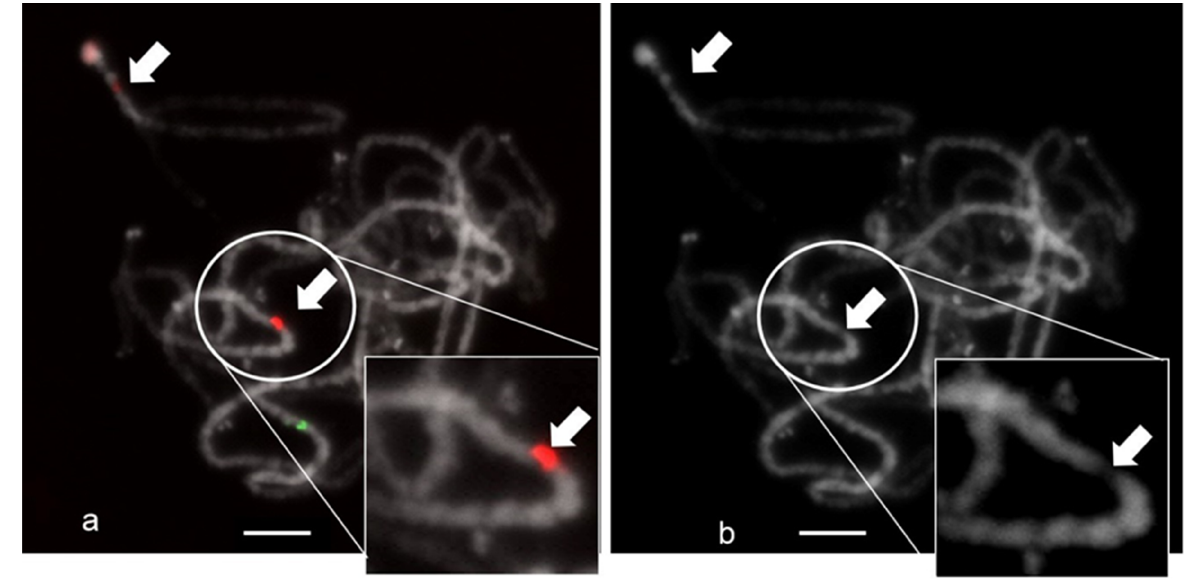
Figure 4. The results of FISH experiments with the CS-237 probe on pachytene C. sativa chromosomes: ( a )—5S rDNA probe (green) and CS-237 probe (red); ( b )—DAPI. Bar 5 µ m. Arrows mark the localization sites with the euchromatin region.